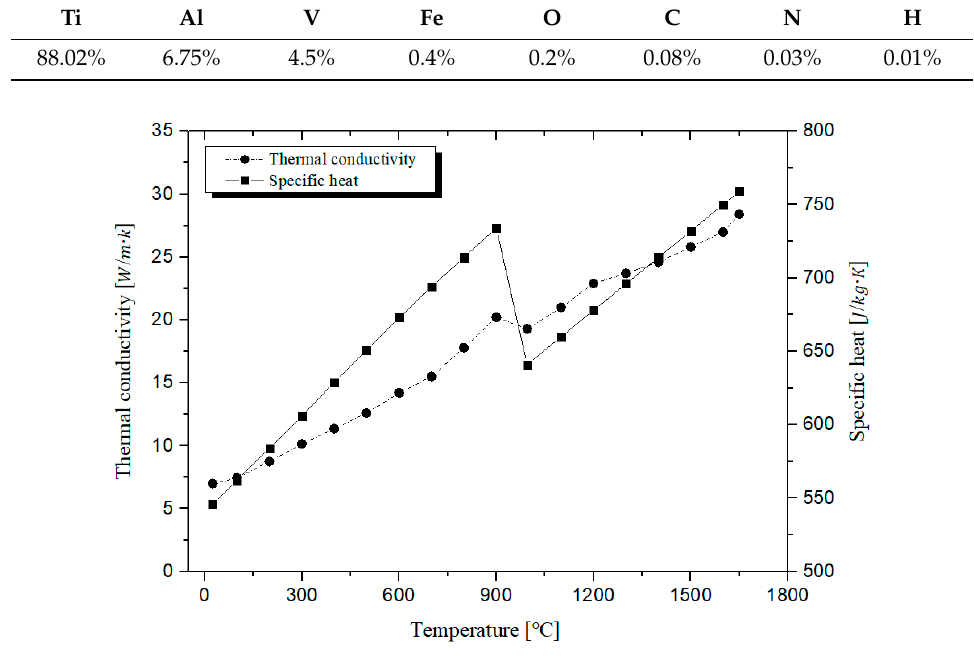
Figure 4. Thermal conductivity and specific heat of Ti-6Al-4V [27,28].